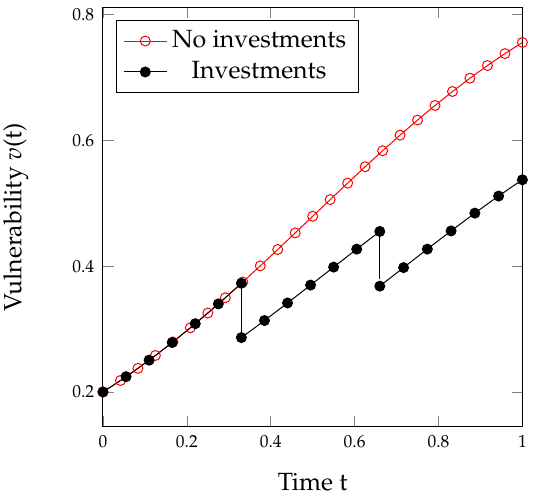
Figure 1. Impact of investments on vulnerability (GL1 model with α = 2.7 · 10 − 5 , β = 1.1) (logistic growth model with V = 0.95, k = 2.68) (attack probability q =